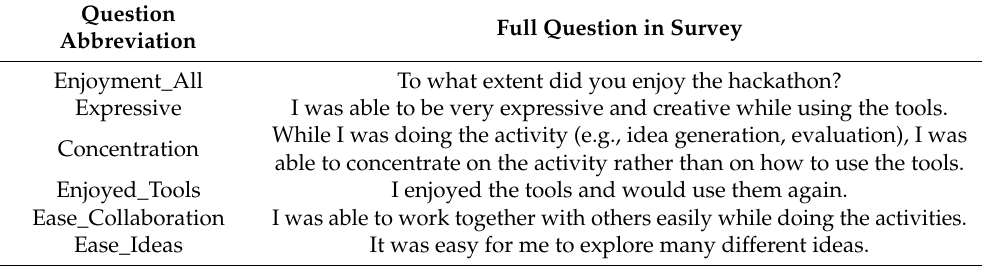
Table 5. Questions involved in the hypothesis testing.